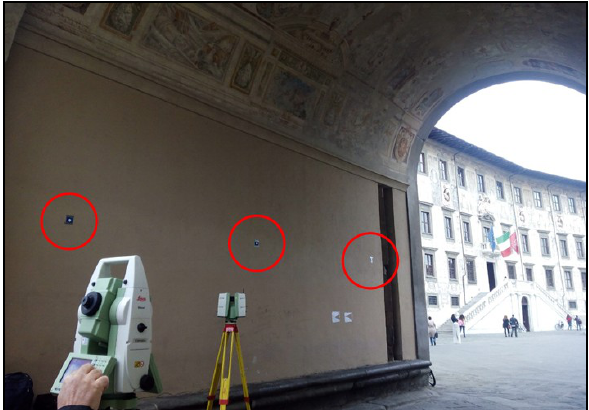
Figure 17 – View of the survey of Leica HDS 3’’ targets (circled in red colour) and location of “Leica C-10” TLS.